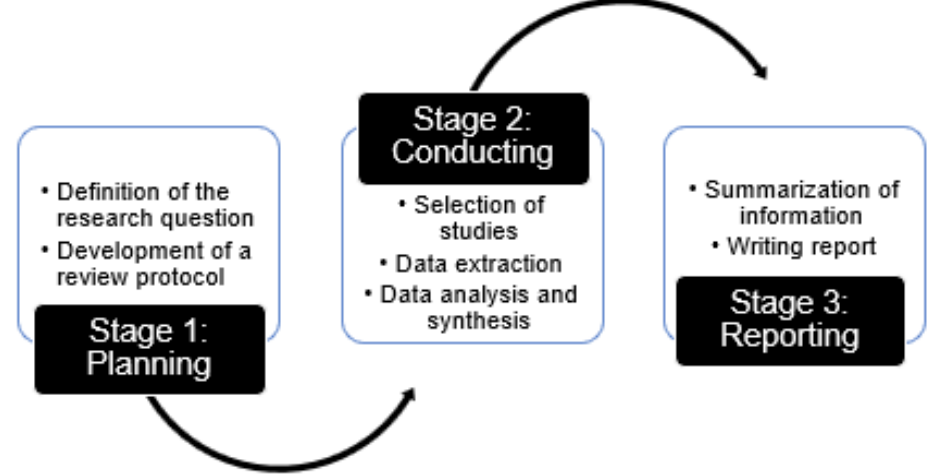
Figure 1. Systematic literature review stages.